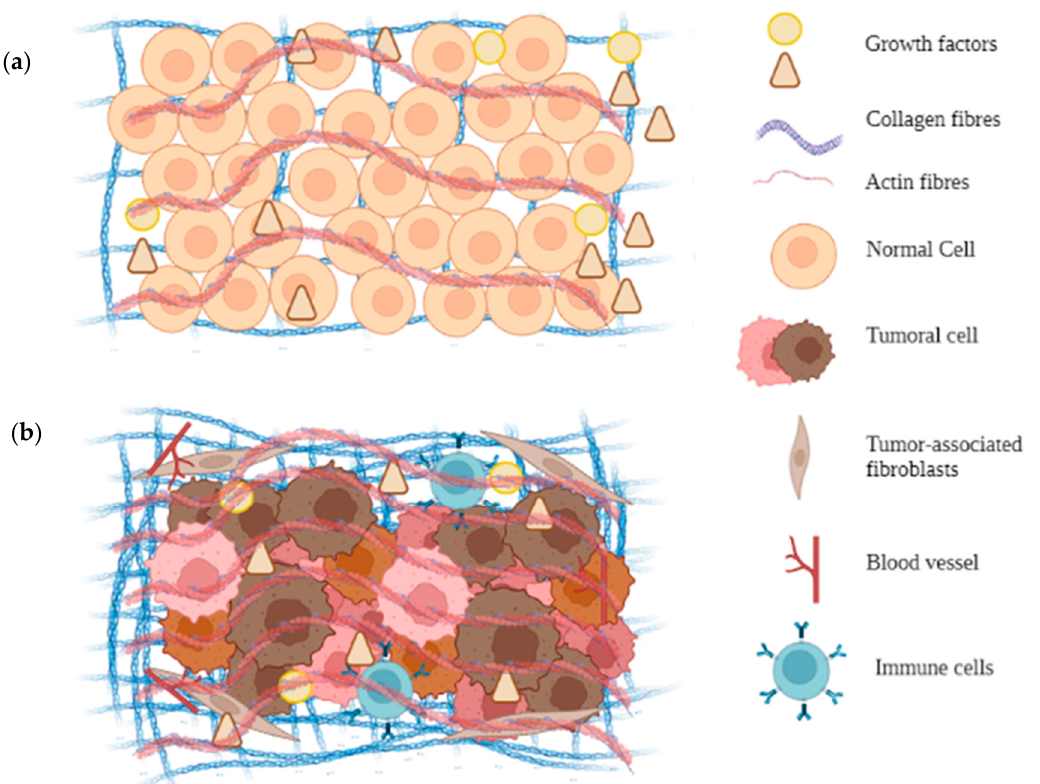
Figure 3. Comparison between the architecture of healthy cell tissue and tumor tissue. ( a ). Architecture of a healthy tissue and ( b ). architecture of a solid cancer tumor. Created with BioRender.com